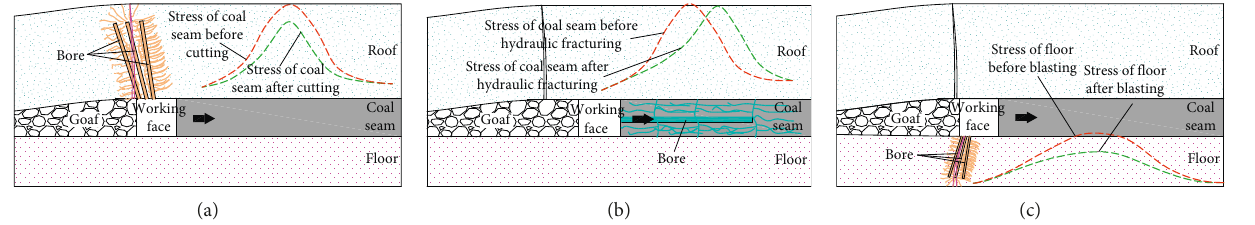
Figure 15: Prevention measures. (a) Blasting broken roof. (b) Hydraulic fracturing of coal. (c) Floor blasting.